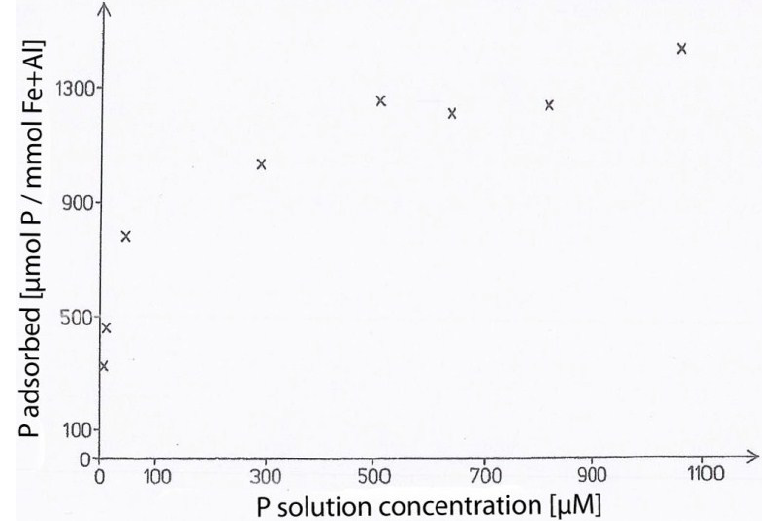
Figure 1. Adsorption of myo -inositol hexa kis phosphate to native humic-Al(Fe) complexes at pH 6.2 in 0.1 M NaCl from Gerke [27] (p.